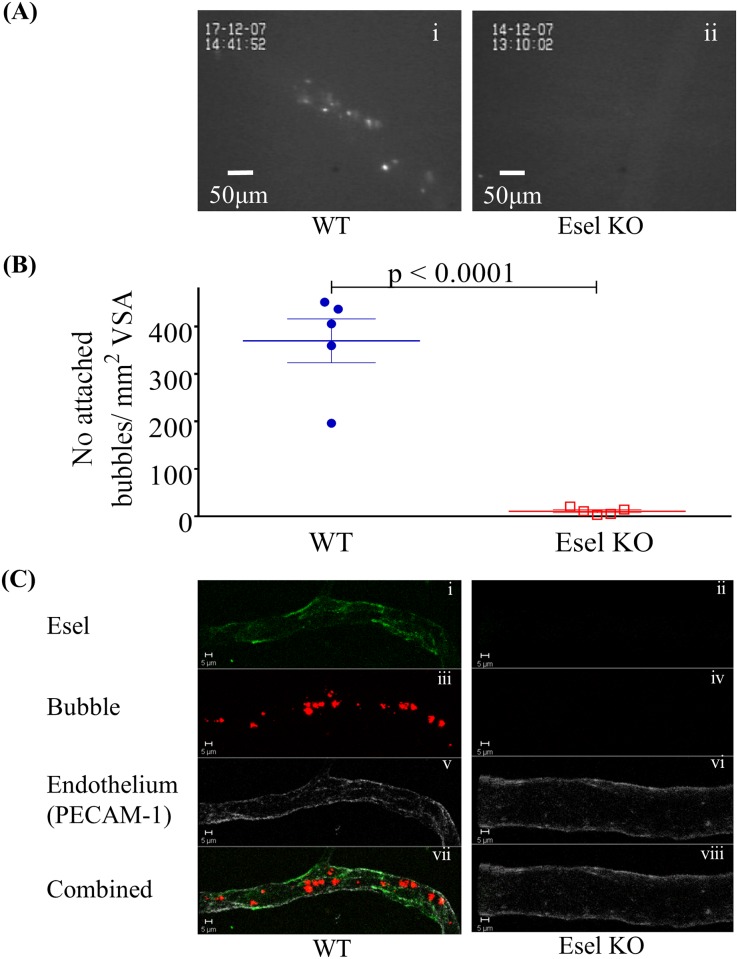

In vivo validation of Esel targeting microbubbles.Intravital microscopy of Esel targeting bubbles in the mouse cremaster. (A) Fluorescence microscopy (SIT camera images, magnification 200x) of attached bubbles in a representative WT (i) and Esel KO (ii) mouse of Fig 3B (S1 and S2 Videos). (B) Quantification of bubbles attached to the cremaster venule. Each point represents one animal; group mean and SEM (error bars) are shown; n = 5 WT and 5 Esel KO. (C) Confocal microscopy of Esel targeting bubbles in the mouse cremaster venule. Esel in green (i, ii), bubbles in red (iii, iv), endothelium (PECAM-1) in grey (v, vi), all 3 components combined (vii, viii).